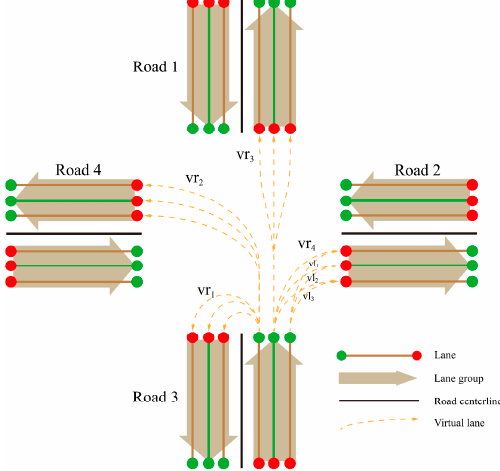
Figure 3. An intersection used to illustrate the model.